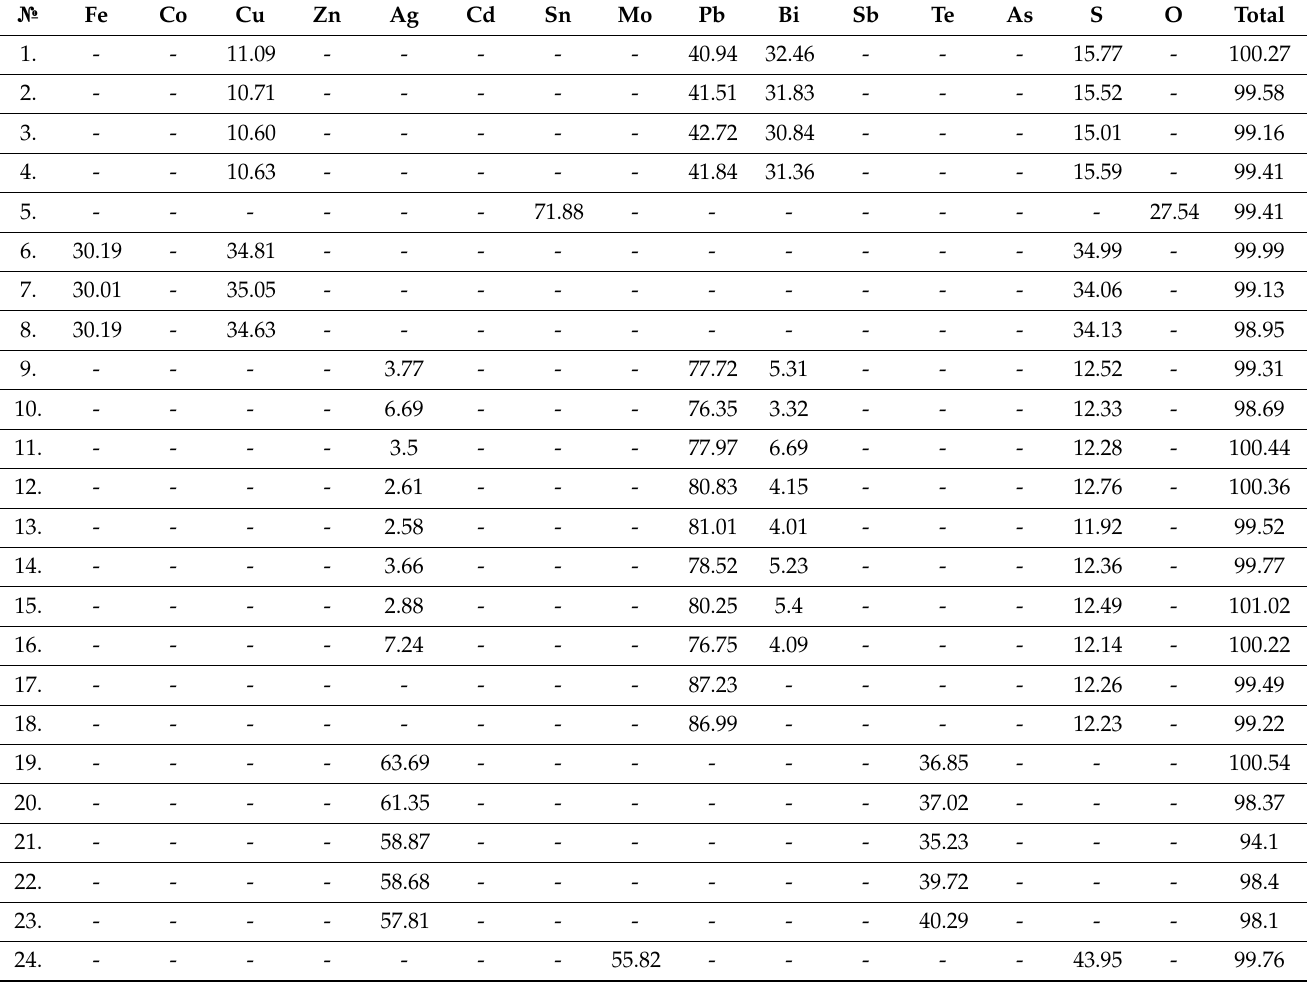
Table 4. Chemical composition of ore minerals from the Inkur